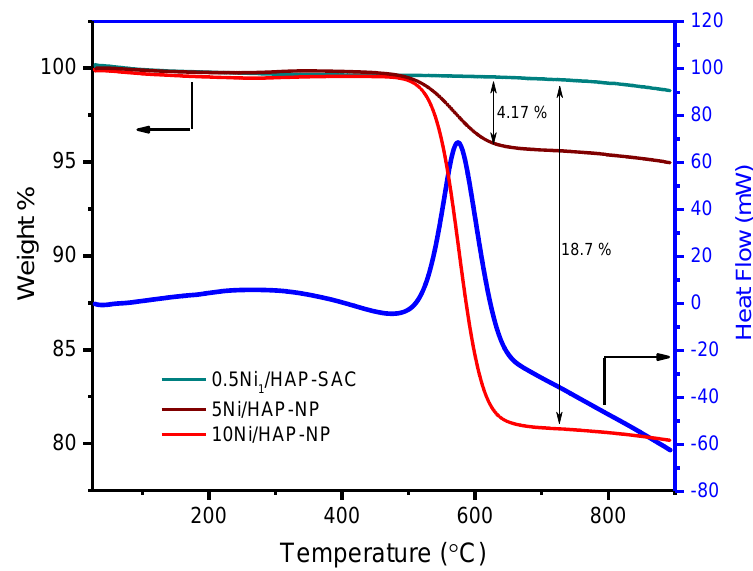
Figure 10. TGA profiles and DSC of the spent Ni / HAP nickel catalysts.